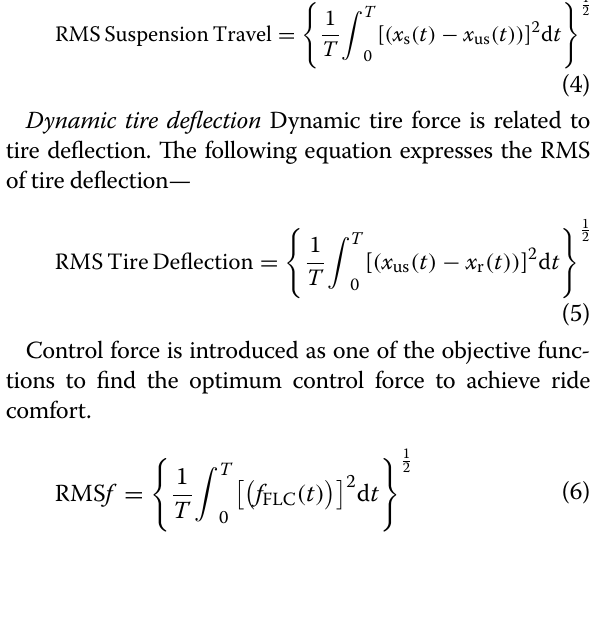
Suspension travel Suspension travel is characterized by the relative travel between the sprung and unsprung mass.